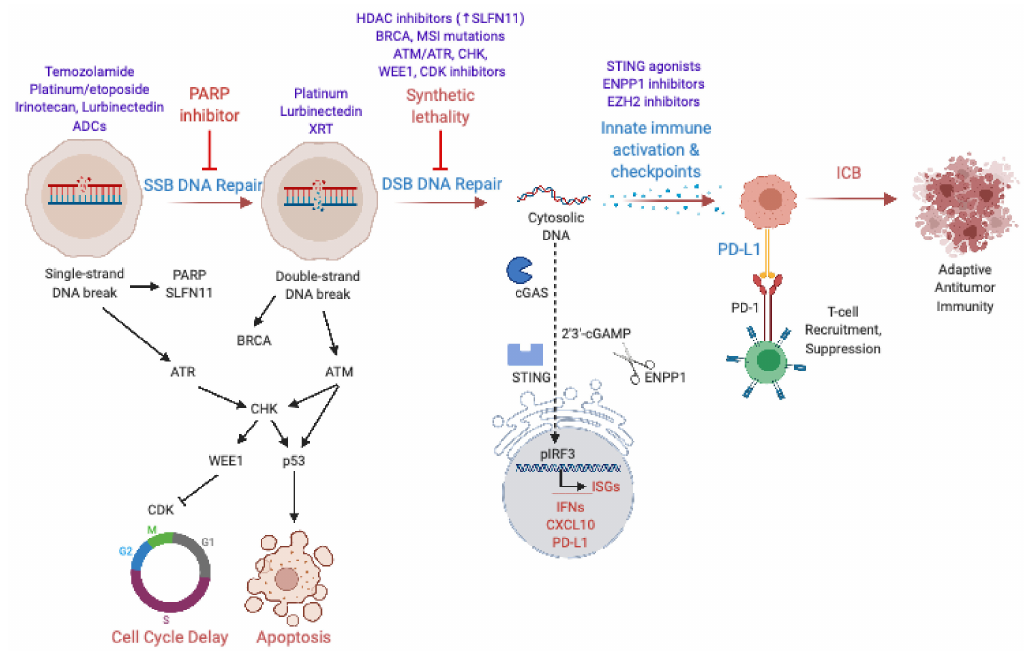
Figure 2. PARP Inhibitor Combinations: Enhancing Response in SCLC. PARP = poly-(ADP)-ribose polymerase, ADCs = antibody–drug conjugates, SSB = single-strand DNA break, DSB = double-strand DNA break, CDK = cyclin- dependent kinase, XRT = radiation therapy, HDAC = histone deacetylase, MSI = microsatellite instability, ssDNA = single- strand DNA, ISGs = Interferon-stimulated genes, and ICB = immune checkpoint blockade. Created with BioRender.com; accessed 29 on January